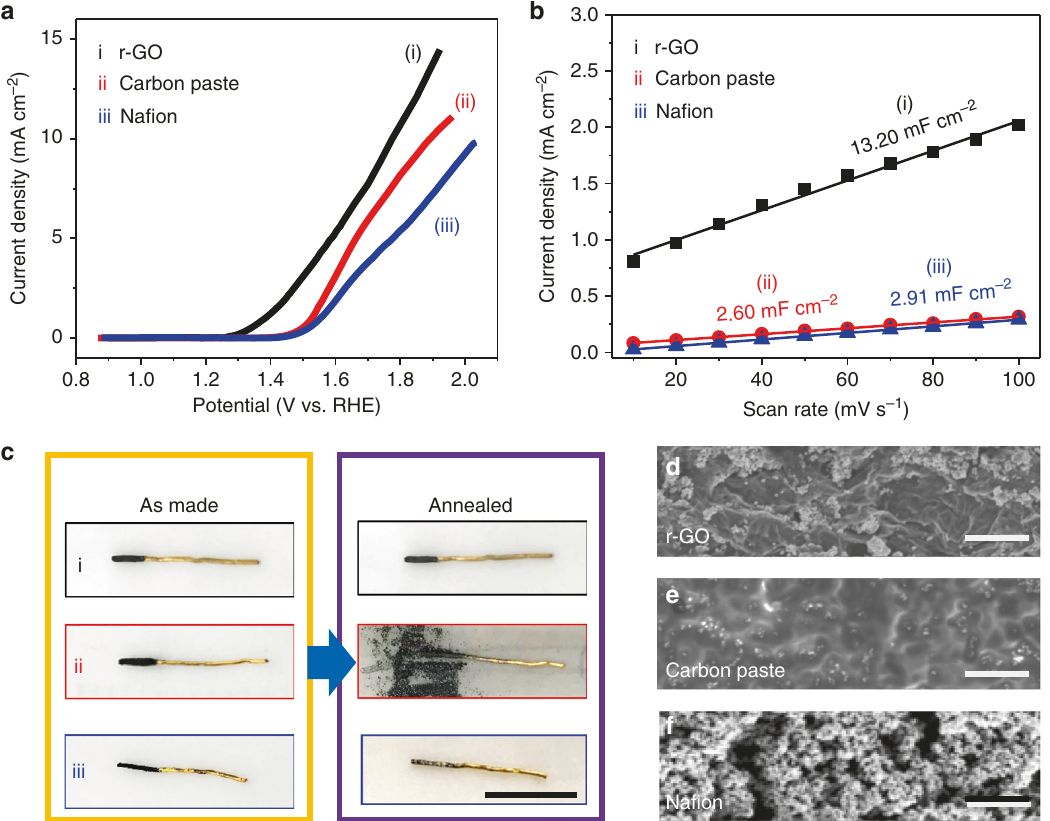
Fig. 5 GO dough as a compliant support for electrocatalyst. a The linear sweep voltammetry curves of OER carried out in 0.1 M KOH using three different RuO 2 electrodes made with annealed GO dough (i), carbon paste (ii), and Na fi on (iii). b The electrochemical surface area of the three types of RuO 2 electrodes. c Photos showing the three types of electrodes before and after annealing. The RuO 2 particles are fi xed on gold wires through the three types of binders. d – f The SEM images showing the surface morphology of the three types of electrodes. Scale bar in c is 1 cm, and in d , e , and f are 5 μ (Fig. 5d – f) of the three types of electrodes con fi rmed that RuO 2 particles are indeed more uniformly dispersed in the r-GO support.